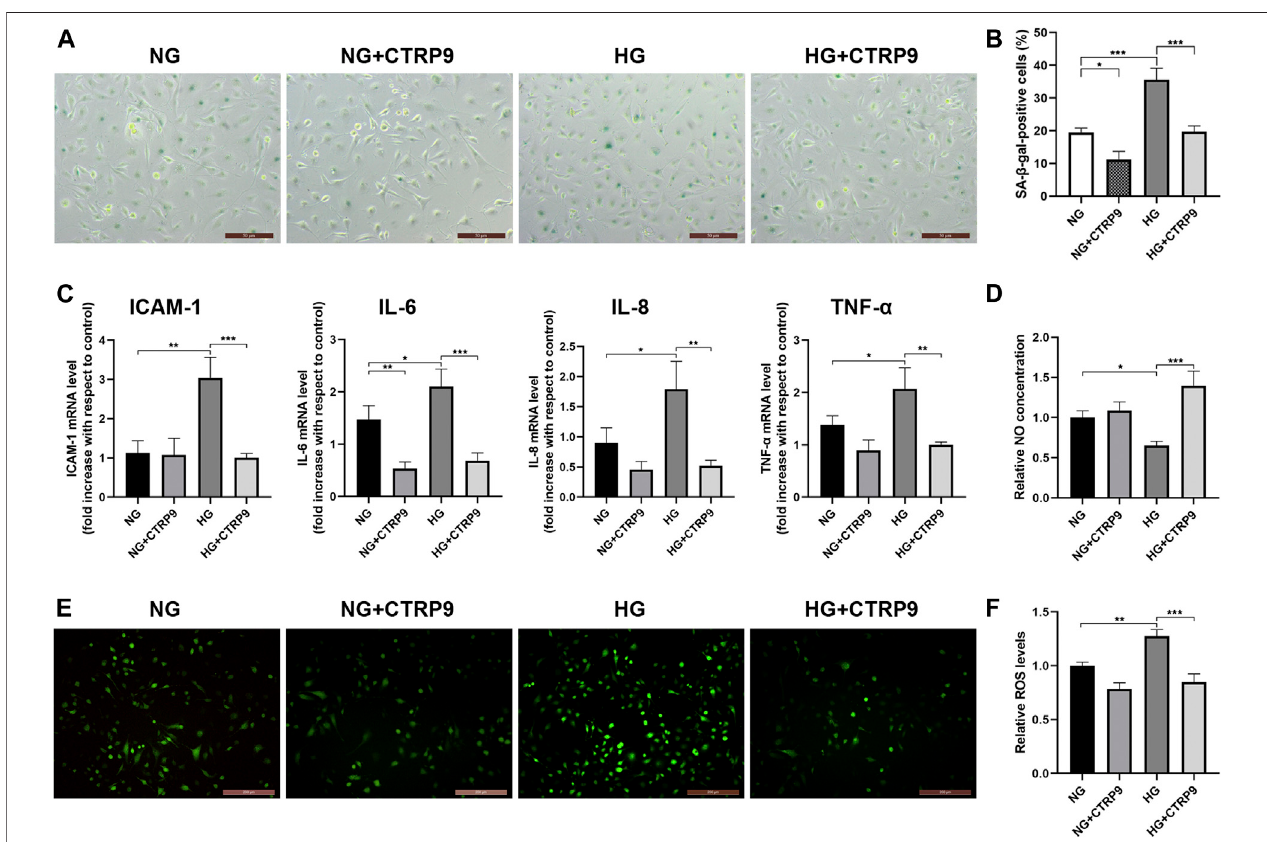
FIGURE3| CTRP9alleviatesHG-inducedsenescence,SASP,andHUVECdysfunction. (A) Cellswere fi xedandstainedforSA- β -galactivity.Theimagesaretaken by × 10magni fi cation. (B) Histogram represents the quantitative analysis of SA- β -gal-positive cells per microscopic fi eld . (C) Cell lysates were used to detect several key SASP component cytokine mRNA levels by qRT-PCR. Results were normalized to controls, and histograms represent the relative intensity of IACM-1, IL-6, IL-8, and TNF- α levels. (D) Total NO production in the culture medium was determined by the modi fi ed Griess reaction method, and the histogram represents the relative intensity of NO. (E) Cells were fi xed and stained with dihydroethidium to detect intracellular ROS levels. The images were taken at × 100magni fi cation. (F) The histogram represents the relative intensity of fl uorescence signal per microscopic fi eld. Values represent mean ± SEM ( n (cid:2) 3 – 4 per group). * p < 0.05, ** p < 0.01, *** p < 0.001.